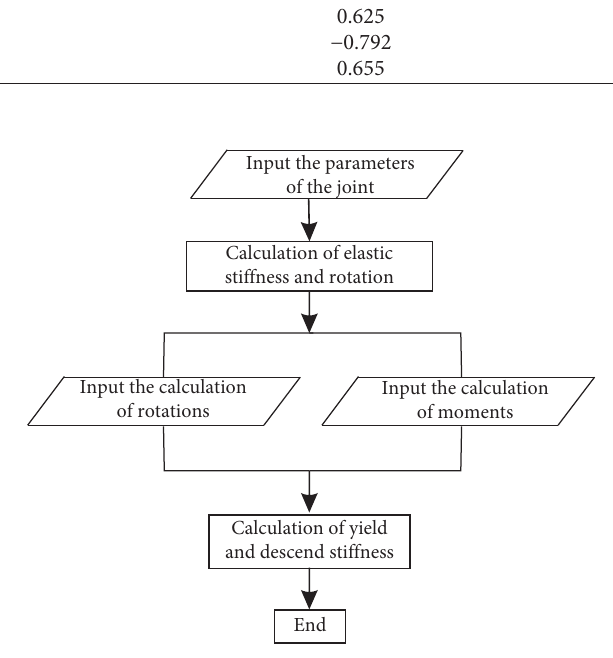
Figure 10: Calculation flow chart for constructing the simplified trilinear skeleton